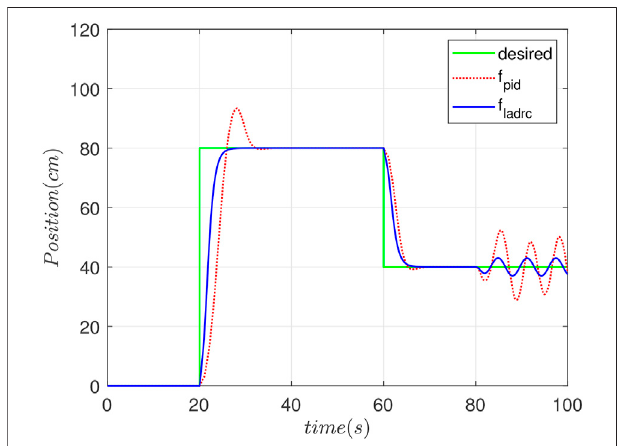
FIGURE 2 | The comparison results of PID and the LADRC position